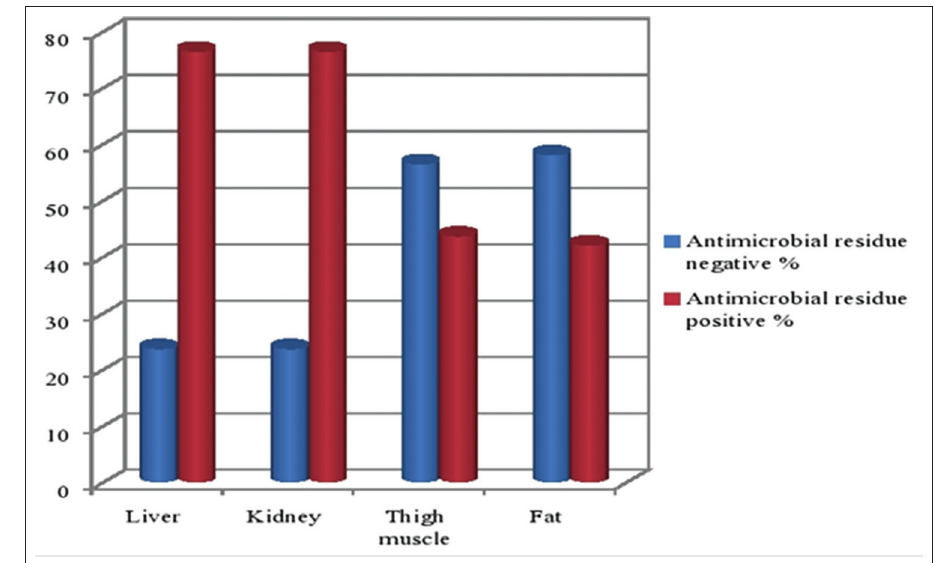
Figure-1: Presence of antimicrobial residues in different tissues of beef